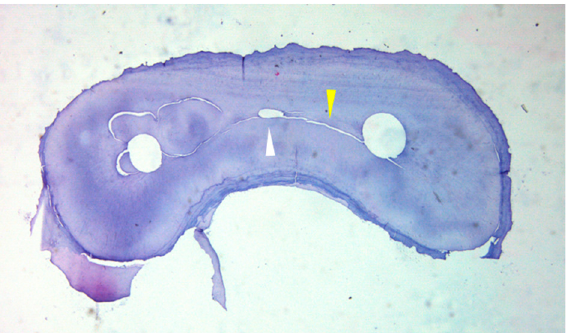
Figure 15. Histologically sectioned mesial root of the mandibular first molar at 3 mm level from the apex after canal shaping. The white triangle indicates an unprepared middle mesial root. The yellow triangle indicates the isthmus connecting the canals.